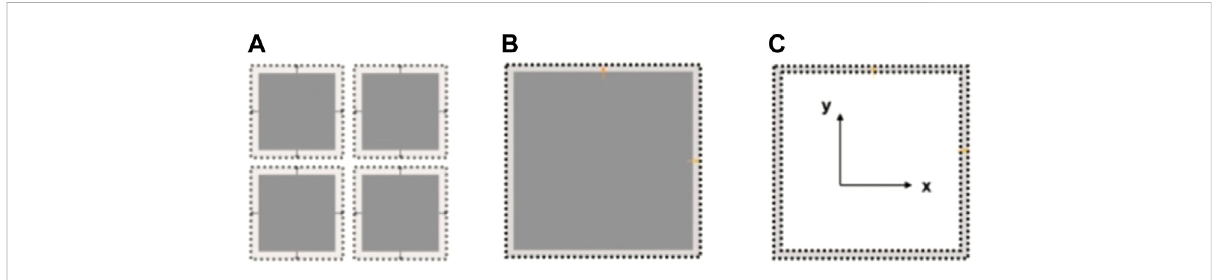
FIGURE 16 Schematic diagram of unconstrained adsorption induction experiment. (A) Matrix medium model with pores; (B) Continuum matrix model; (C) Matrix expansion.